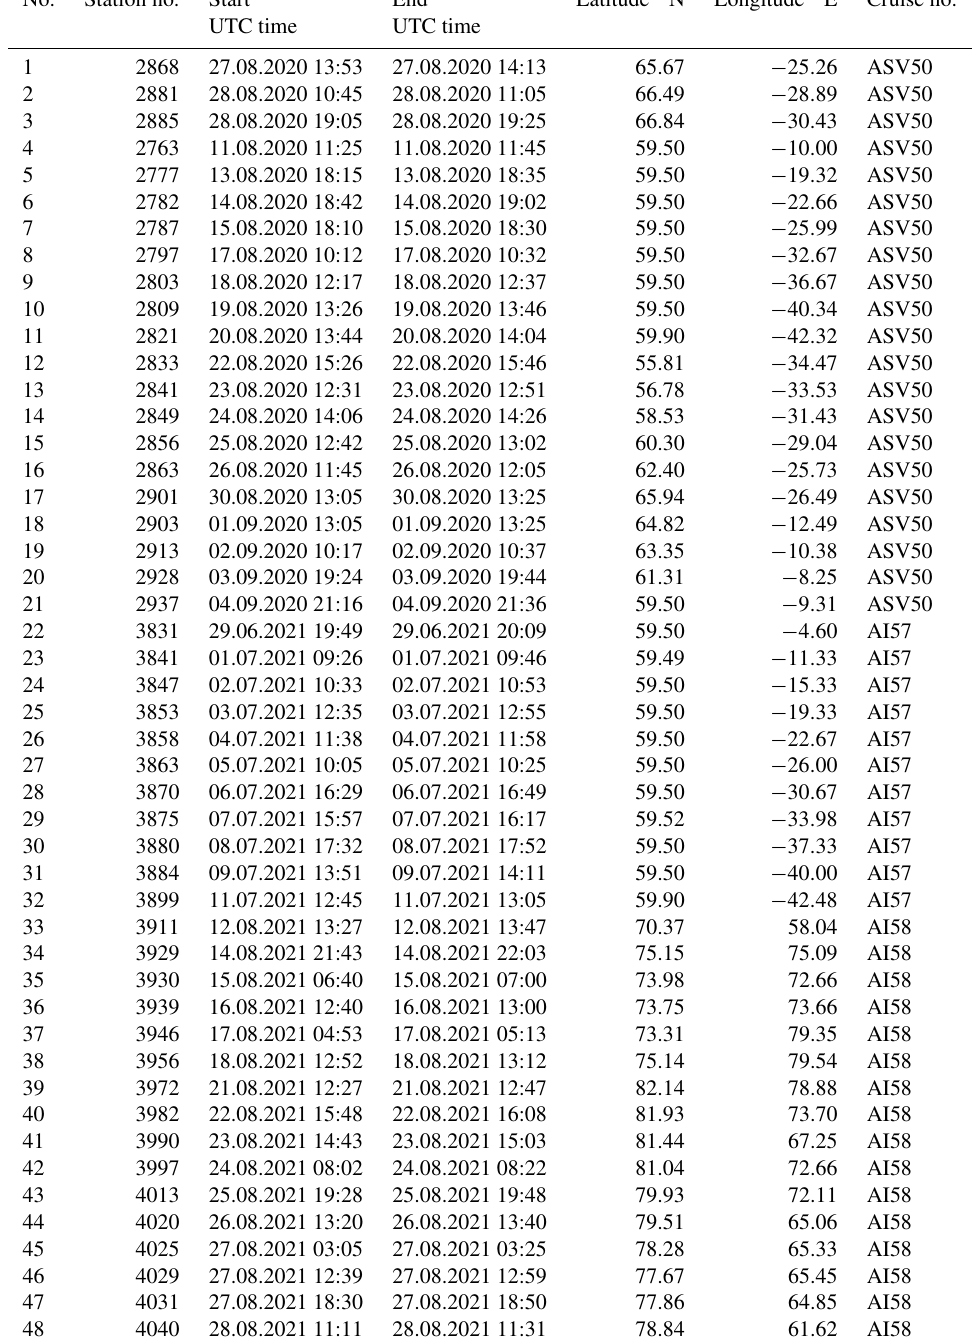
Table A1. Stations list: geographical locations and time of all stations where the wind wave measurements were performed simultaneously with SeaVision and the Spotter buoy. In the last column letters stand for the name of the research vessel (ASV – Akademik Sergey Vavilov , AI – Akademik Ioffe ) and numbers stand for the sequence number of a research cruise since the beginning of the research vessel operation. No. Station no. Start End Latitude ◦ N